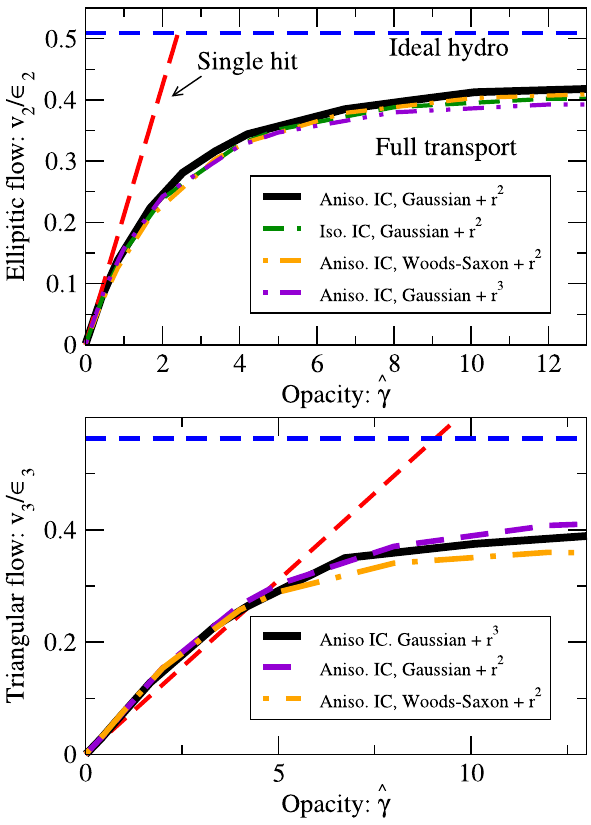
Fig. 5 The linear response v n /(cid:17) n of energy flow coefficients v n to for elliptic (upper panel) and triangular (lower panel) eccentricities (cid:17) n . Dif- ferent radial profiles yield similar results, curves discussed in Sect. 4.4